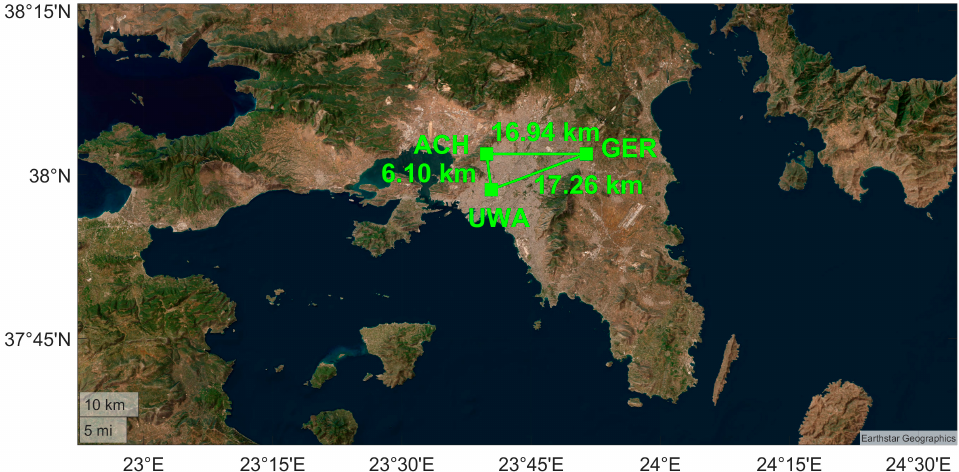
Figure 1. Satellite image of the prefecture of Attica in Greece. The three VLF/LF stations (ACH, GER, and UWA) are depicted with light green squares, while the distance between each pair of them is also shown.